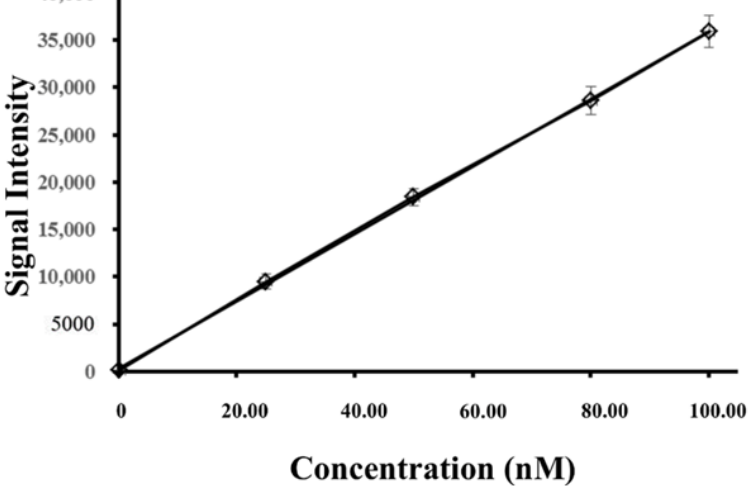
Figure 5. Calibration curve of posaconazole in an aqueous solution under optimized conditions.